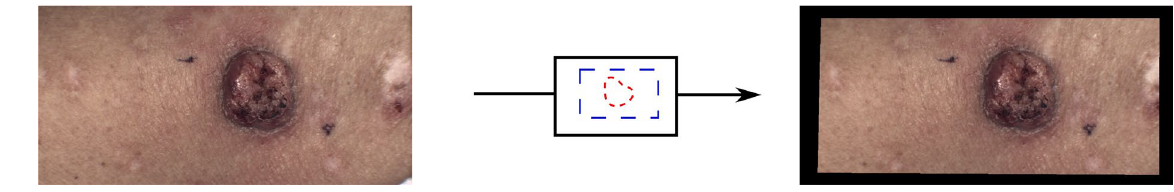
Figure 2. Removal of edges by area mask.